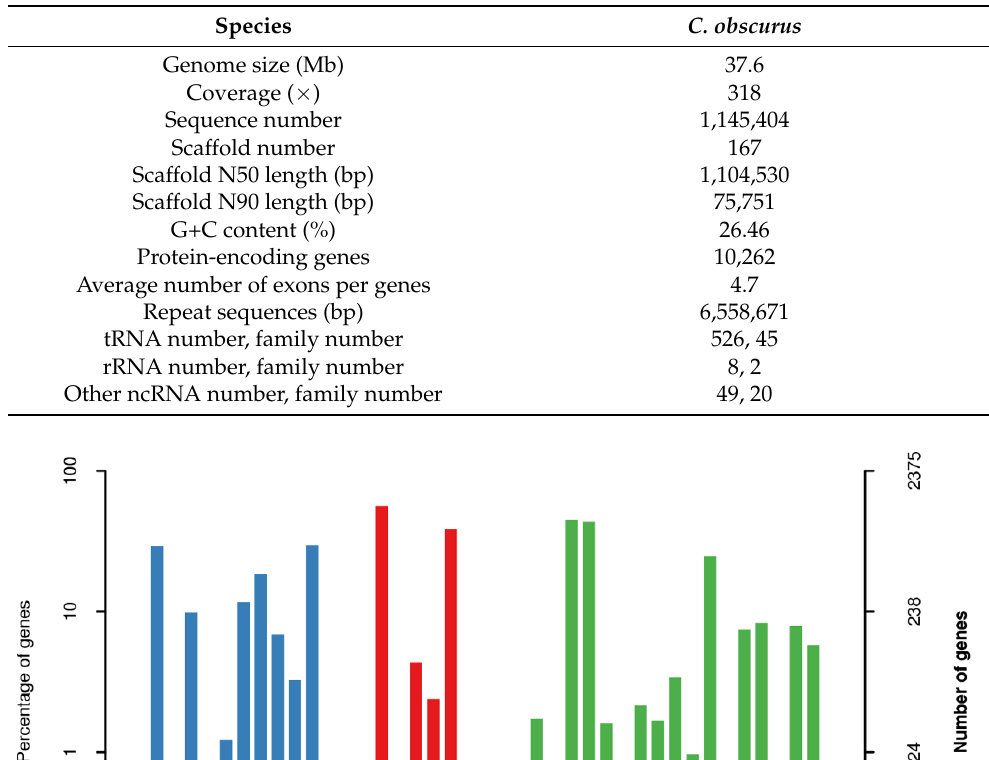
Table 1. Genome characteristics of the aphid-obligate pathogen Conidiobolus obscurus .